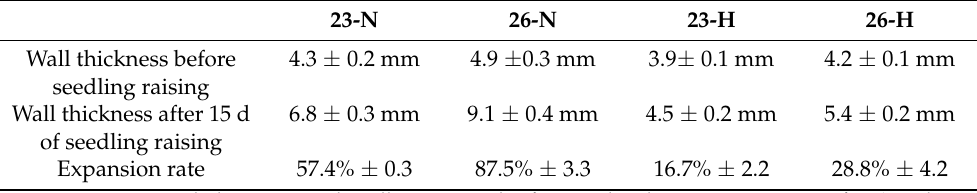
Table 2. Changes in sidewall size from before to after seedling raising.